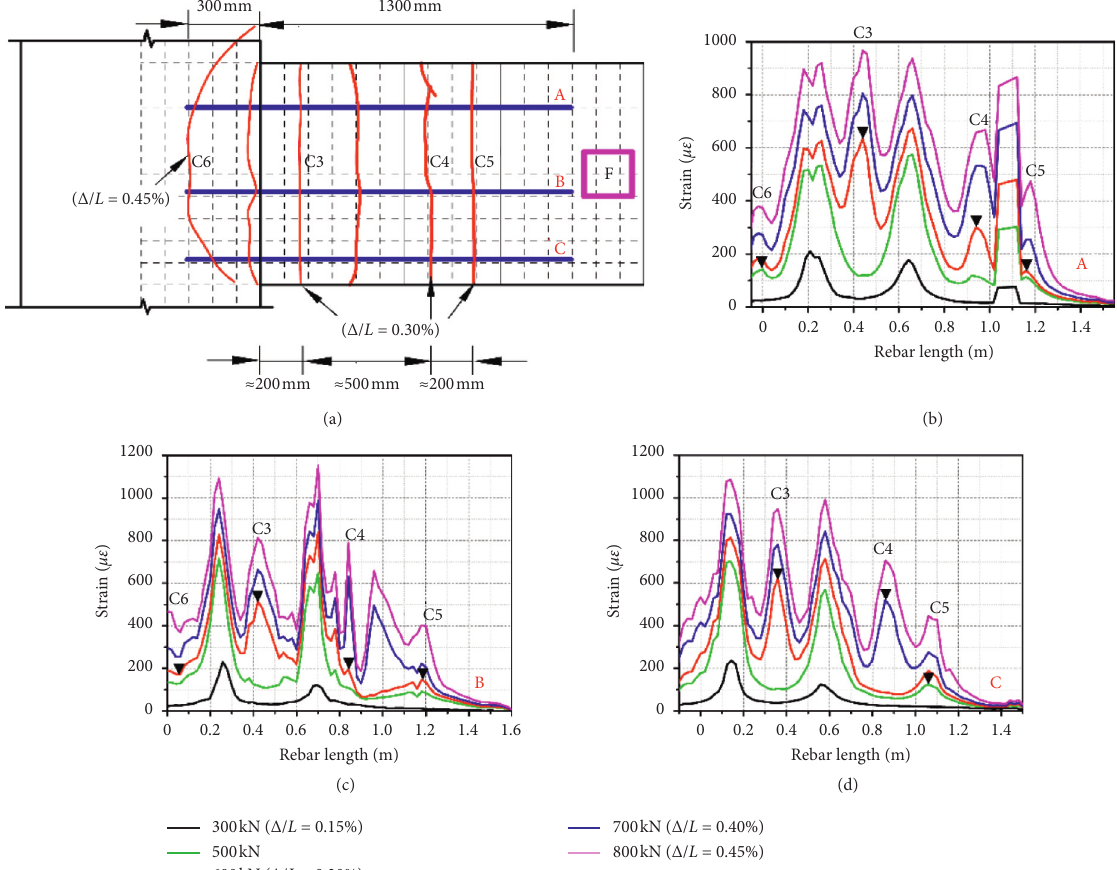
Figure 8: Damage status at 0.45% drift (a) and strain profile measured in top fibers A, B, and C at drift levels below 0.45%